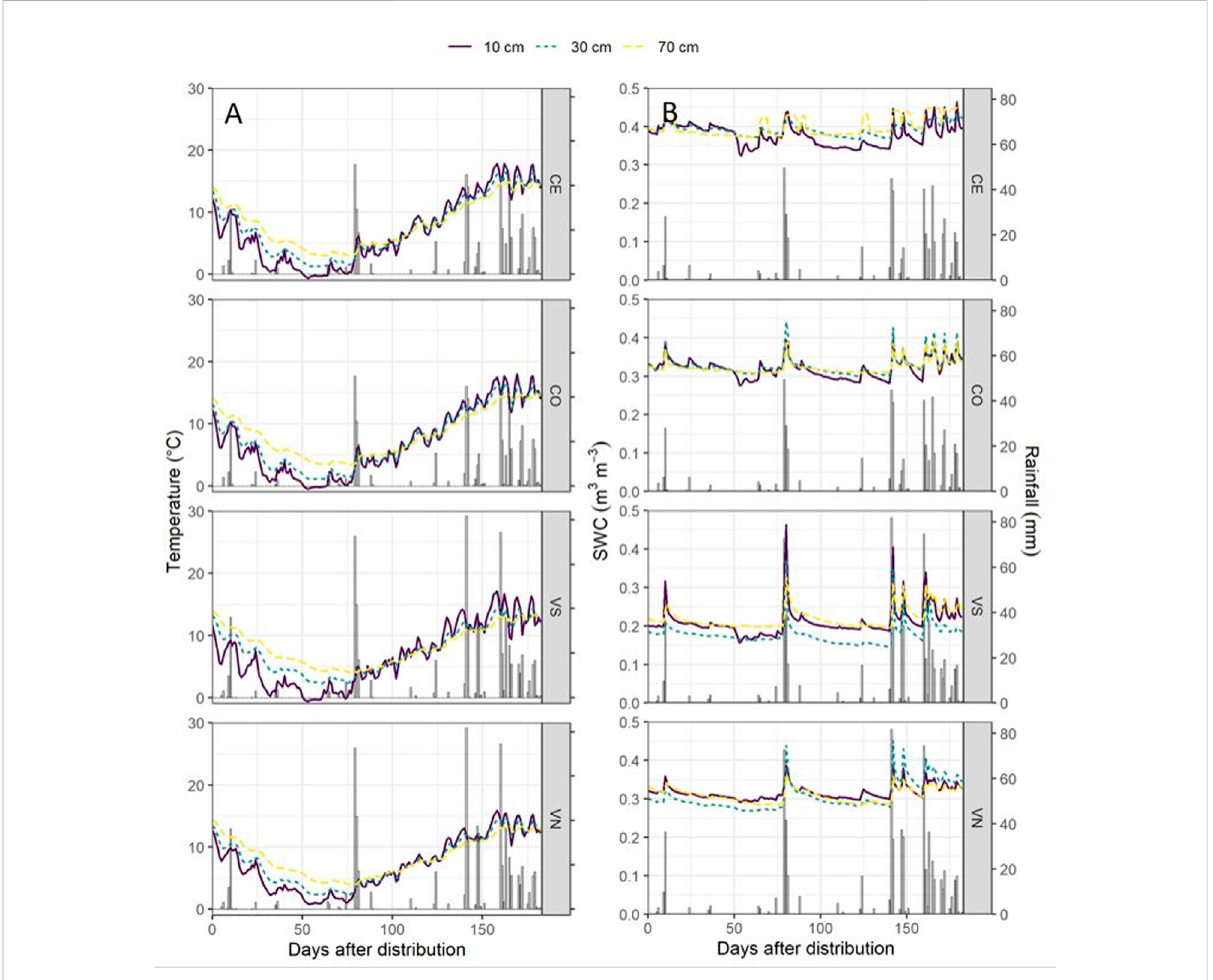
FIGURE 2 Soil temperature ( ° C) (A) and the soil water content (SWC, m 3 m − 3 ) (B) dynamics for the four monitoring stations at the three monitoring depths (10 cm, solid purple line; 30 cm, dotted green line; and 70 cm, dotted yellow line) with rainfall events